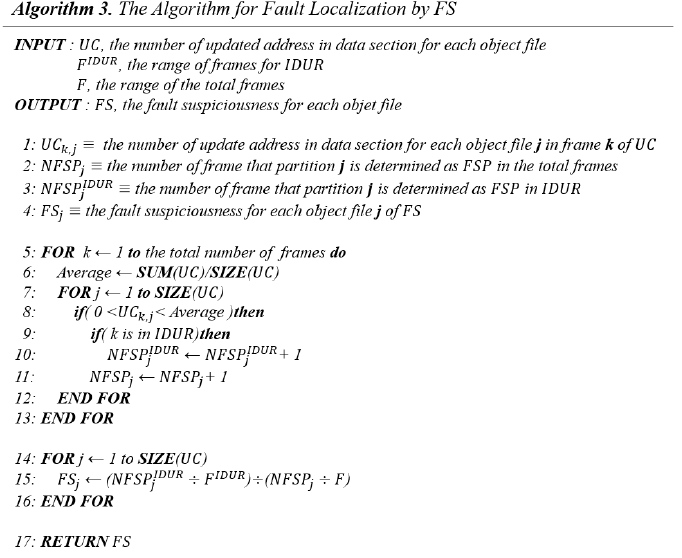
Figure 11. Algorithm for fault localization by fault suspiciousness (FS).